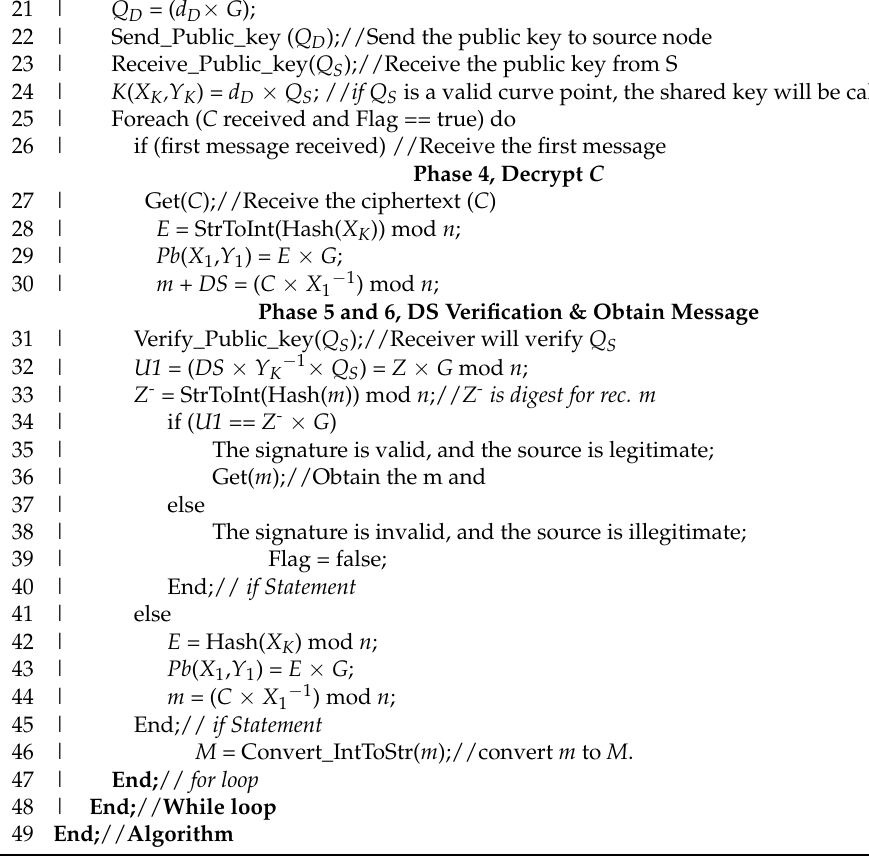
ELCD at IoT Sender